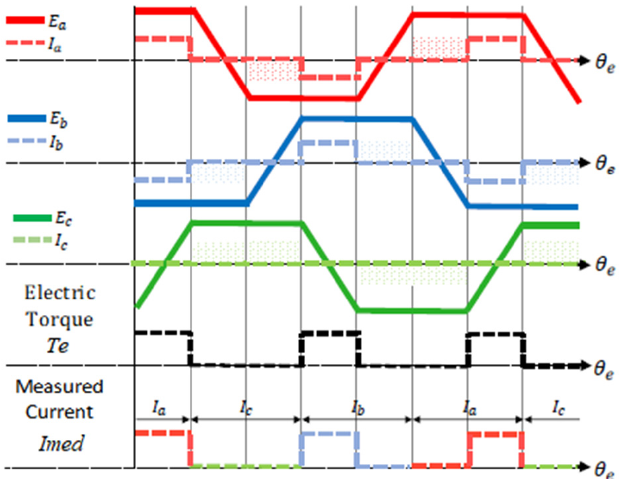
Figure 3. Waveforms of induced voltages, currents, torque, and current observed by the controller a BLDC motor with faut in phase c in 120 ◦ Six-Step operation mode. of a BLDC motor with faut in phase c in 120° Six-Step operation mode.